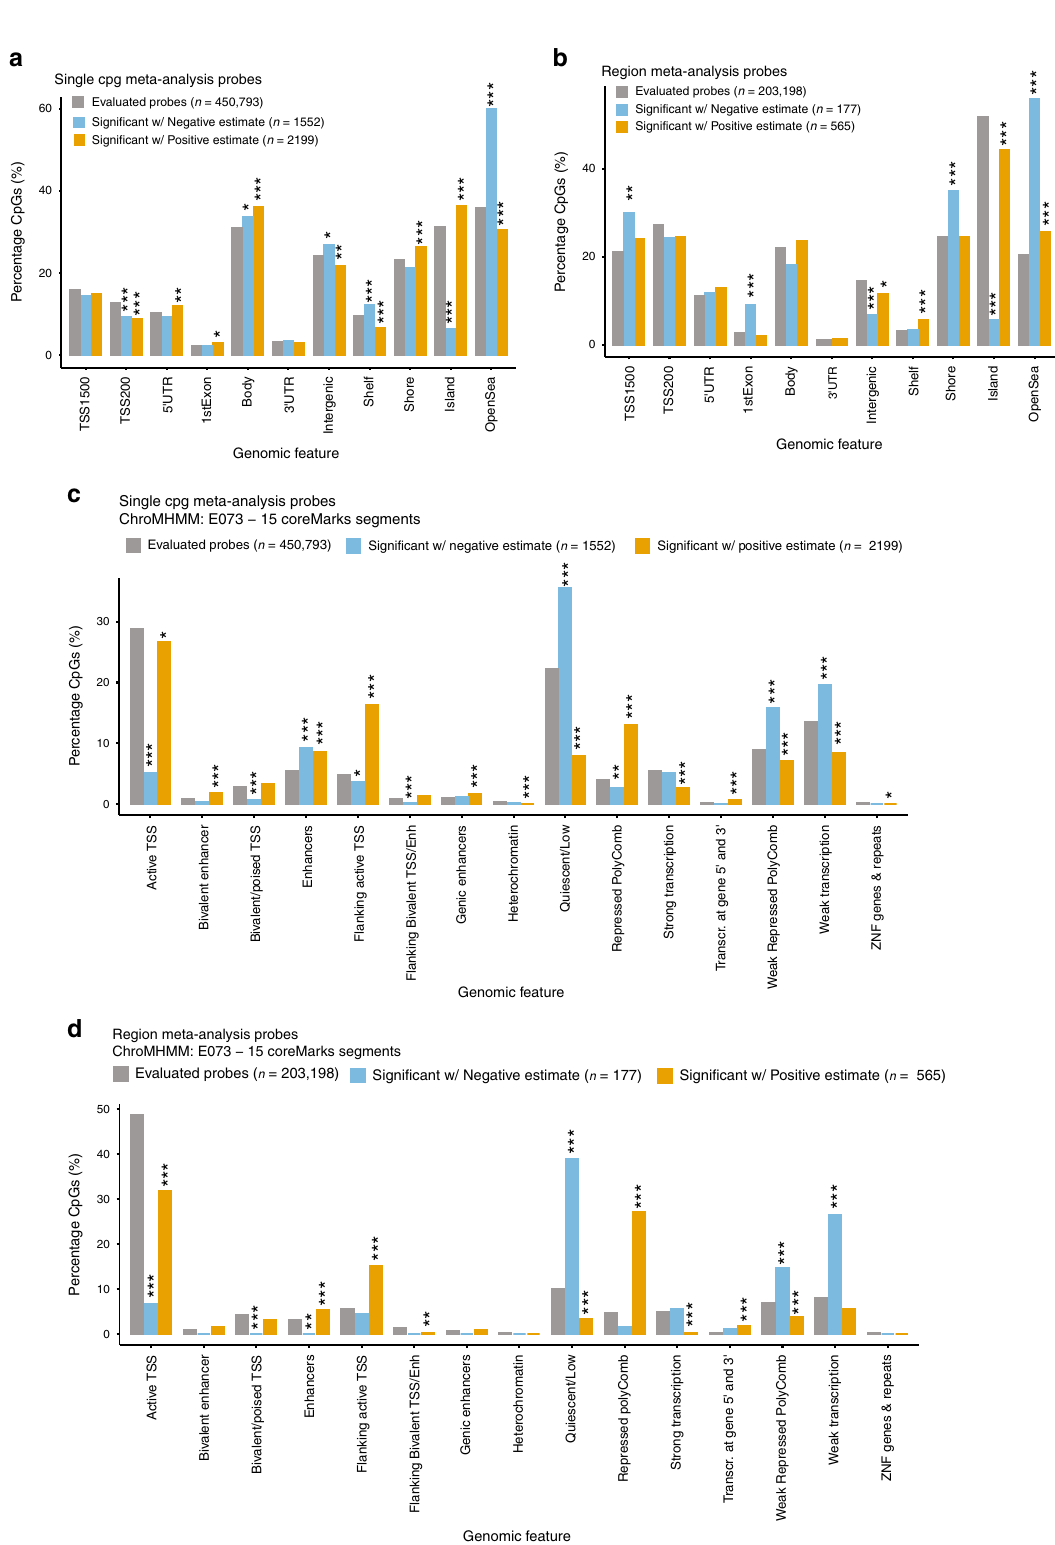
Fig. 3 Enrichment of CpGs signi fi cantly associated with AD Braak stage in meta-analysis of individual CpGs and DMRs at 5% FDR. A two-sided Fisher ’ s test was used to determine over or under-representation of the signi fi cant CpGs in individual CpGs analysis and CpGs mapped within signi fi cant DMRs in various a , b genomic features and c , d chromatin states. *** P -value < 0.001, ** P -value < 0.01, * P -value < 0.05, uncorrected for multiple